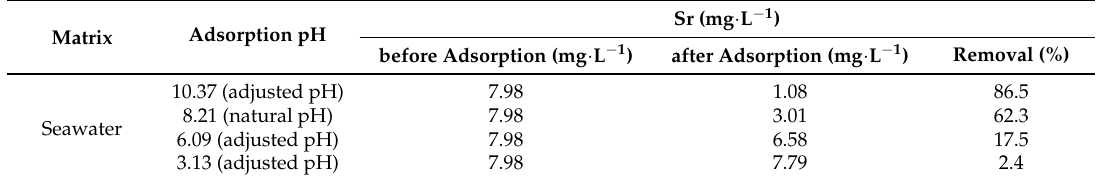
Table 4. Sr removal in seawater using the composite magnetic